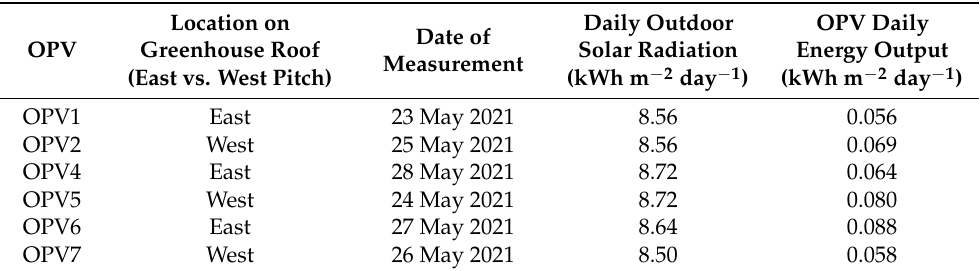
Table 3. Power generation performance of six identical OPV arrays deployed on the greenhouse roof,